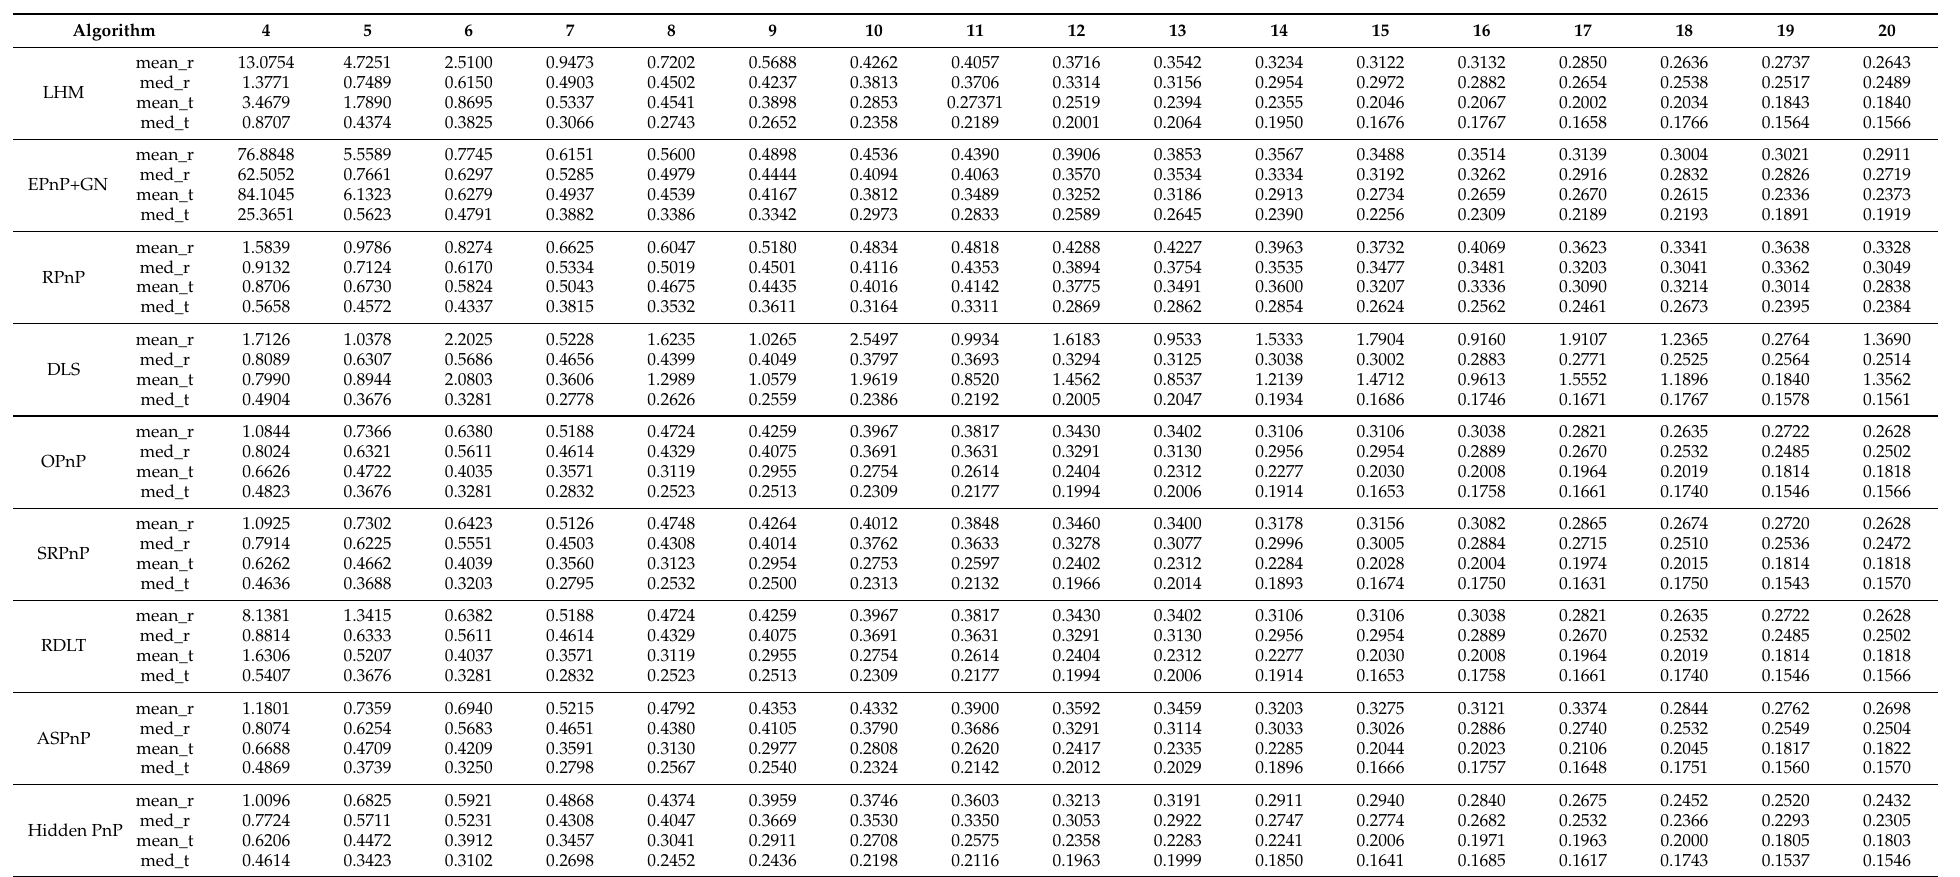
Table A1. Error comparison in the Ordinary 3D